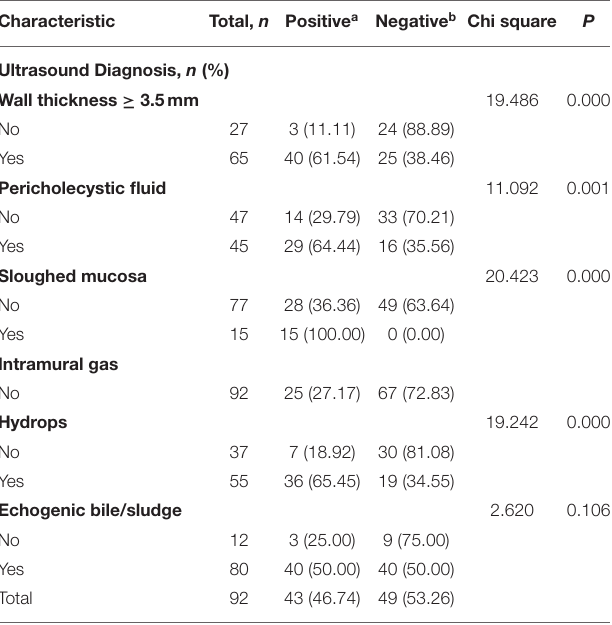
TABLE 2 | Summary of ultrasound imaging characteristics in acute acalculous cholecystitis (AAC) positive and negative groups. Overall patients Included patients n = 374 n = 92